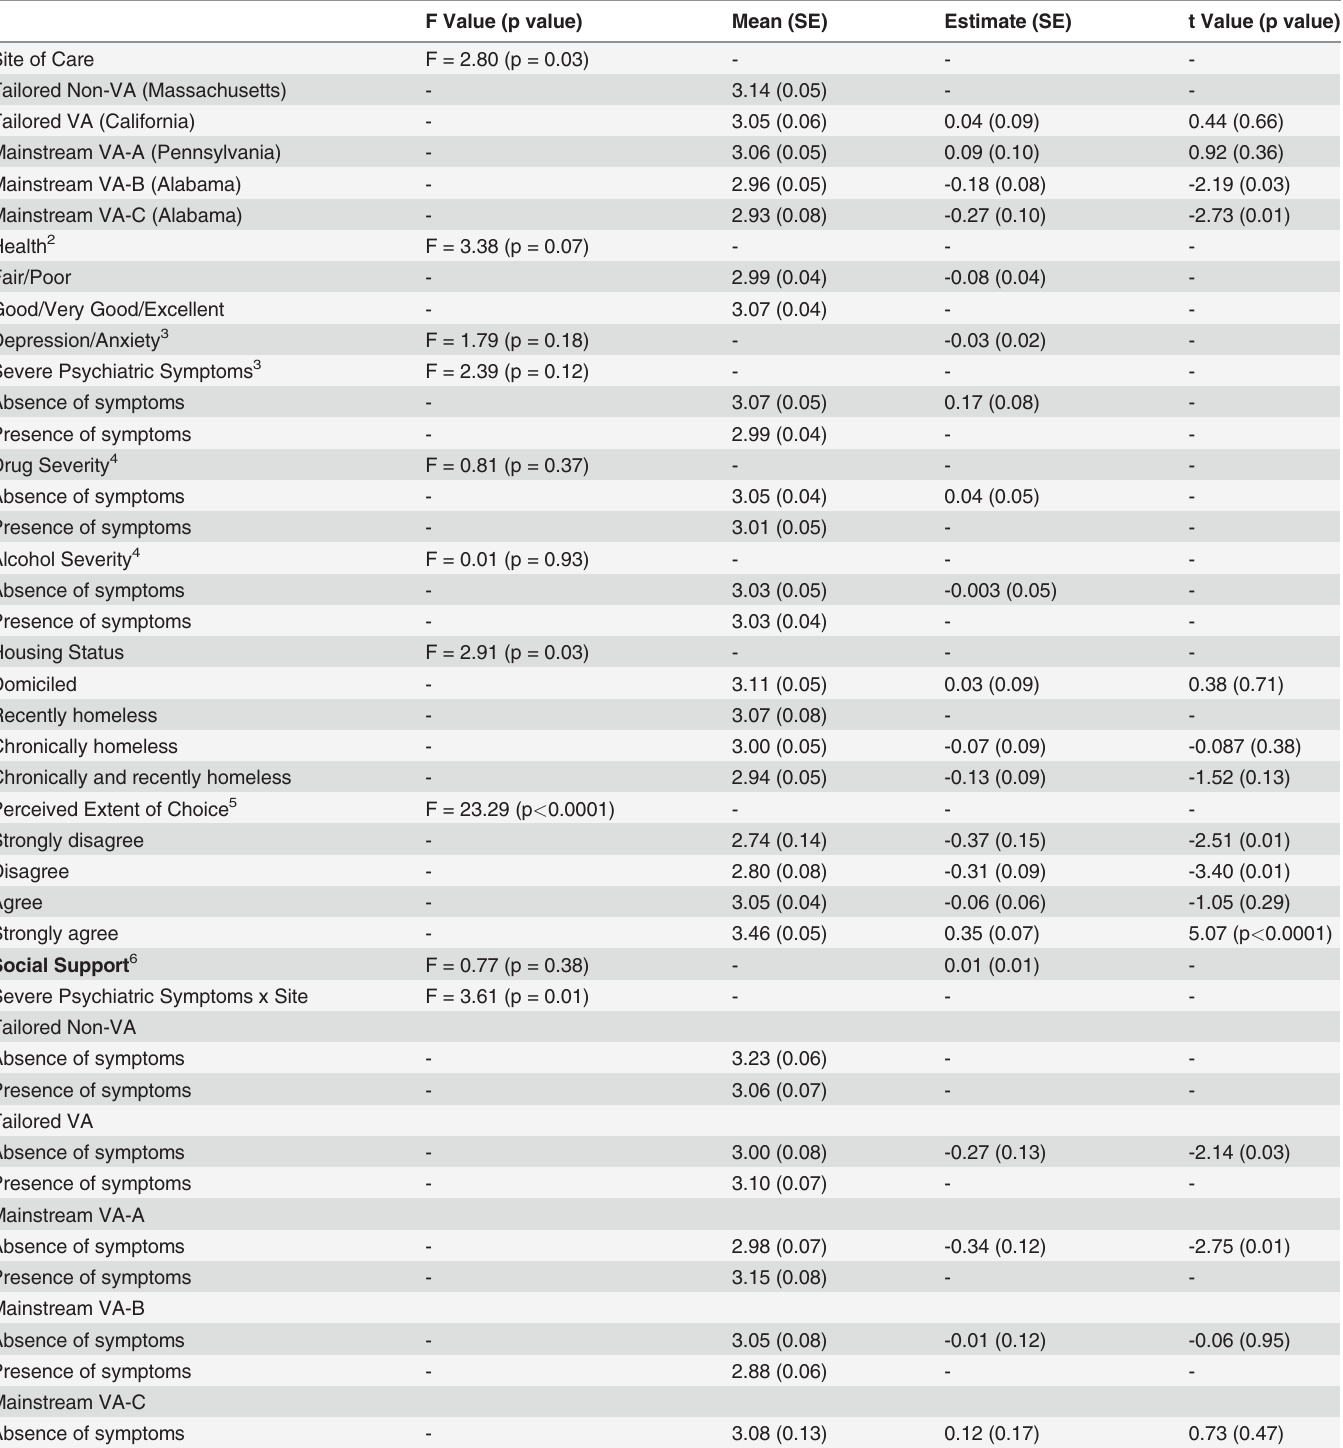
Table 2. The effect of patient and site characteristics on predictors of care experiences among PCQ-H sample population 1 . F Value (p